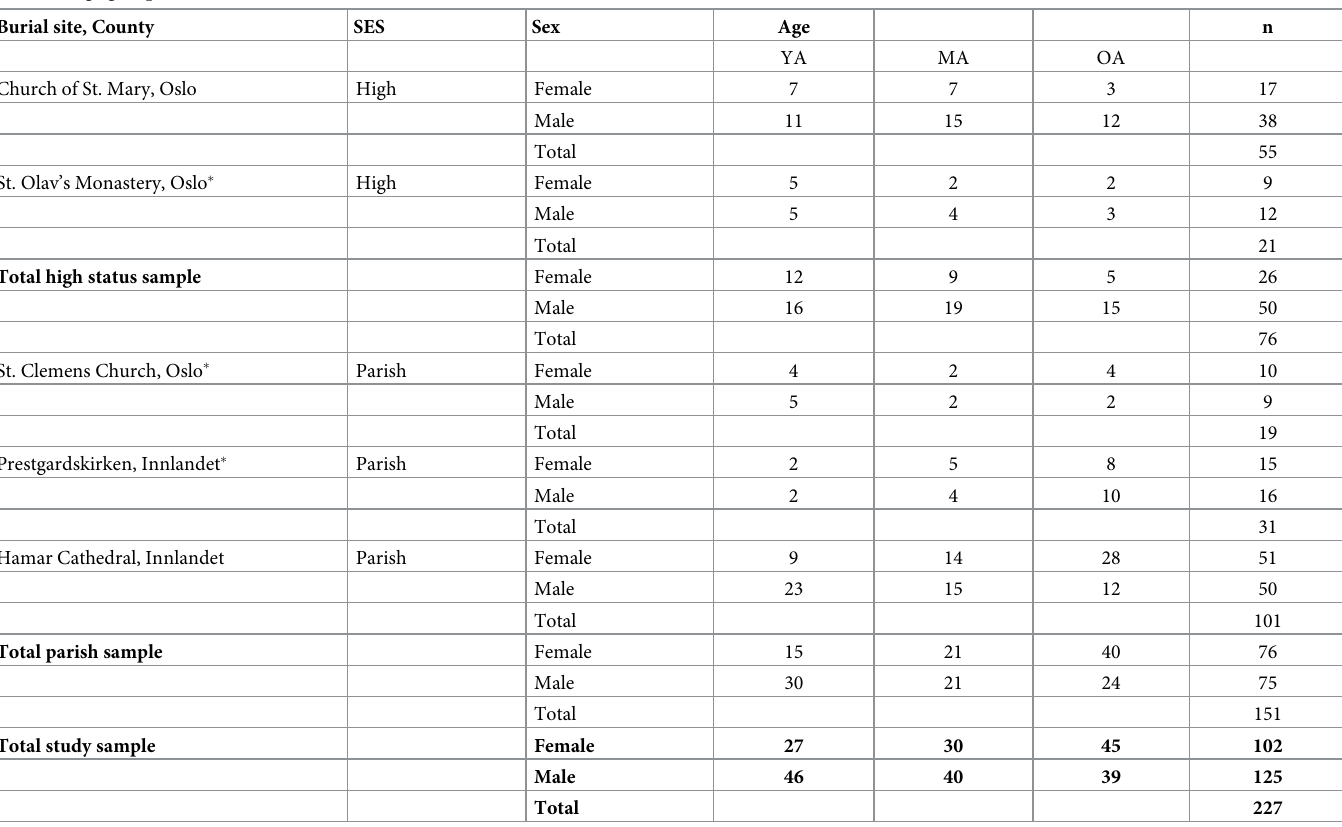
� Data from Holck (2007).